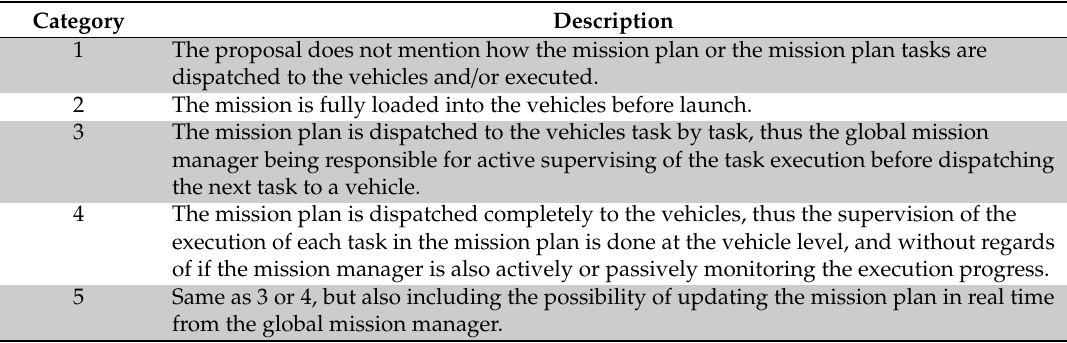
Table 5. Mission plan dispatching and execution